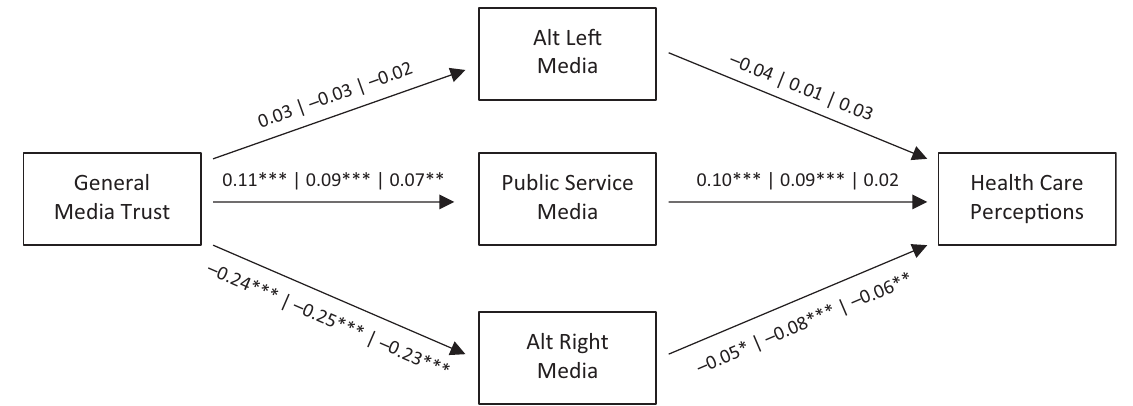
Figure 2. Path model predicting perceptions of Swedish health care. Notes: Path estimates are unstandardized coeffi‐ cients from three separate SEM models (W2, W3, and W4); each media use equation controls for gender, age, political interest, and ideology; the health care equation controls for the lagged dependent variable ( t 𝜒 2 (5) = 61.247, p = 0.000, RMSEA = 0.07, CFI = 0.976; W3 Model—N = 2,326, 𝜒 2 (5) = 19.341, p = 0.000, RMSEA = 0.035, CFI = 0.993; W4 Model—N = 2,316, 𝜒 2 (5) = 50.306, p = 0.000, RMSEA = 0.063, CFI = 0.976; * = p < 0.05, ** = p < 0.01, *** = p < 0.001.